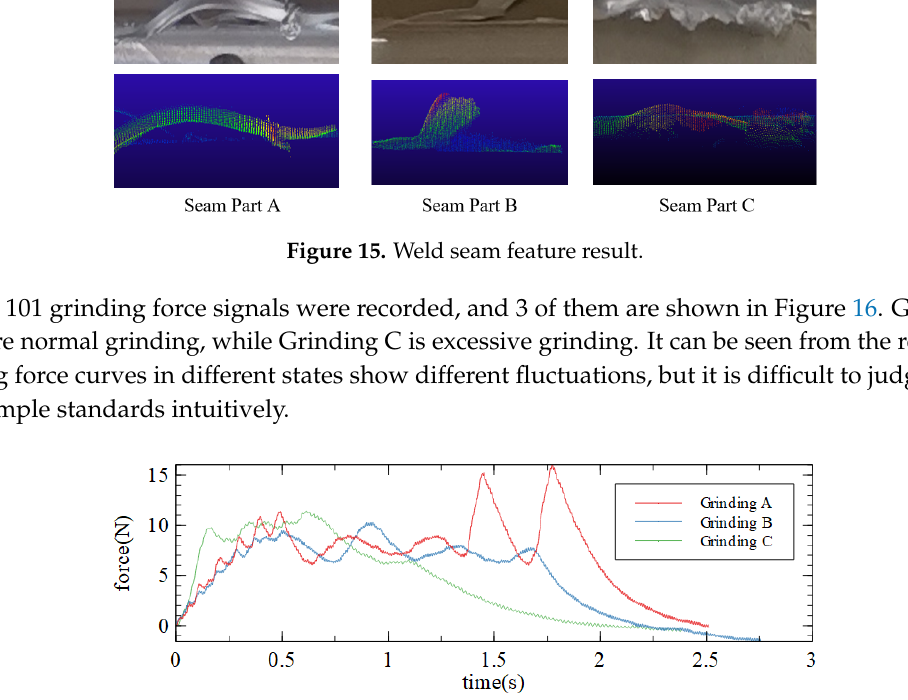
Figure 16. Grinding force